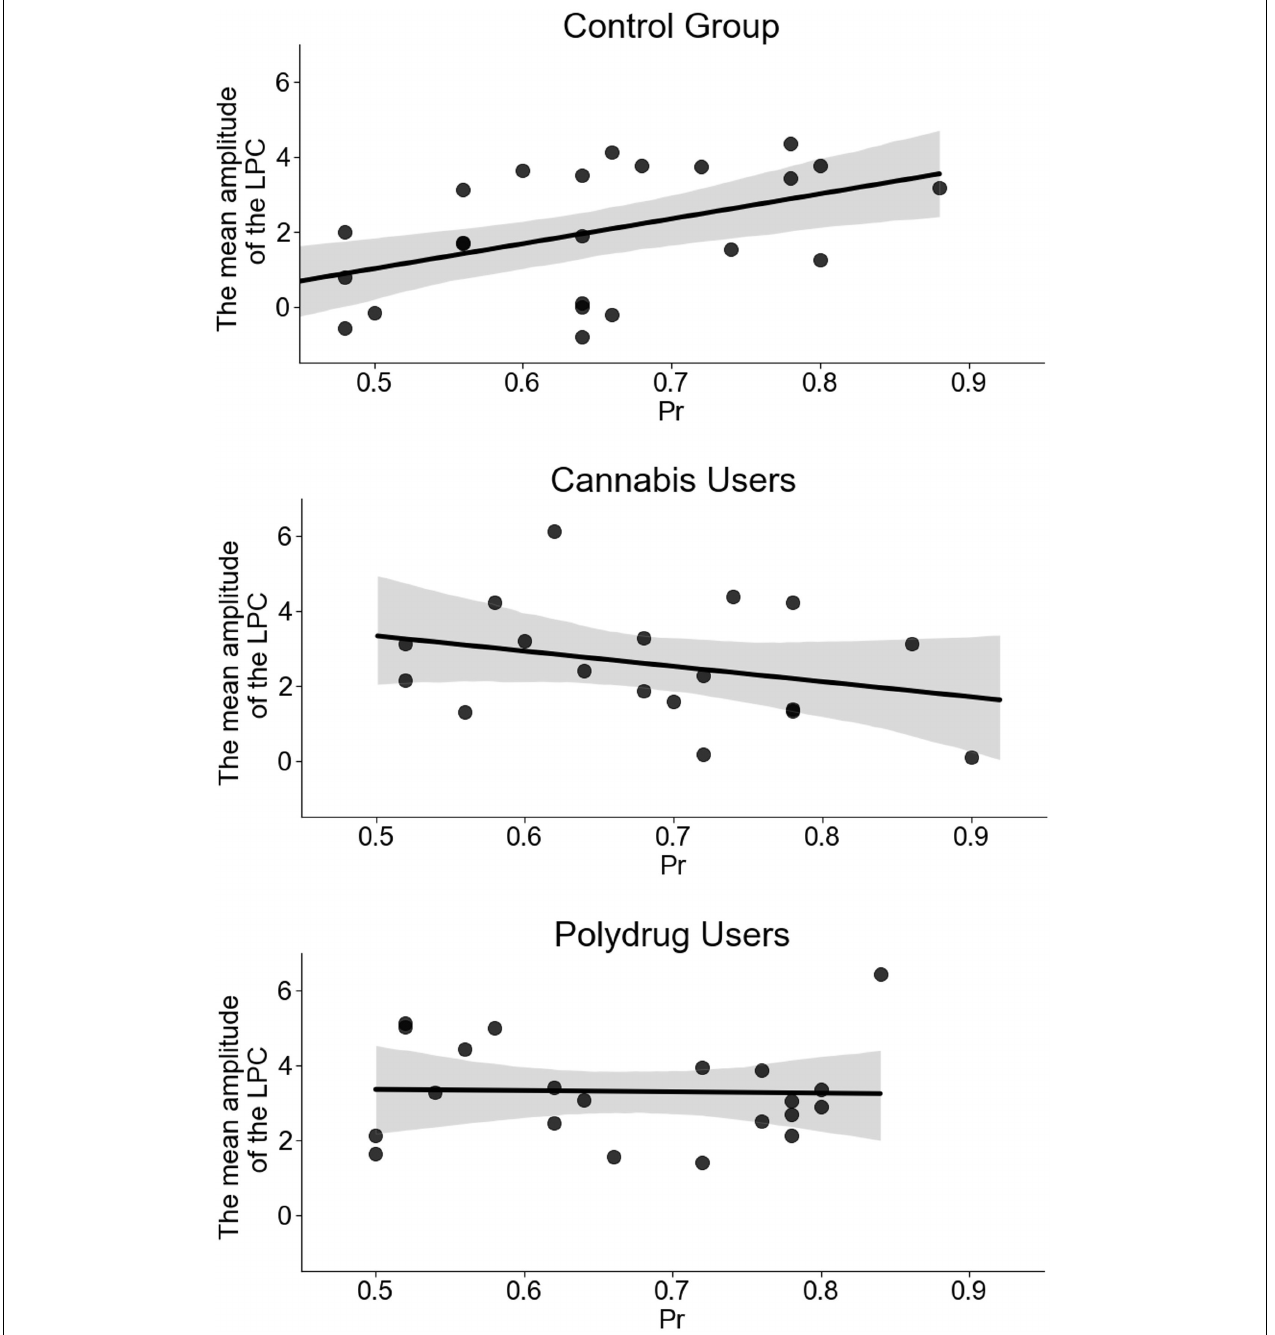
FIGURE 5 | Regression models for recognition accuracy indicator (proportion of recognition, Pr = Hits - False Alarms) as a function of the mean amplitude of the LPC for each group separately. Scatter plot presents a significant relation between the mean amplitude of the LPC and Pr ( r = 0.472, p = 0.02) in control group (CG) and statistically insignificant relations in cannabis users (CU) ( r = − 0.287, p = 0.248) and polydrug users (PU) ( r = − 0.028, p =